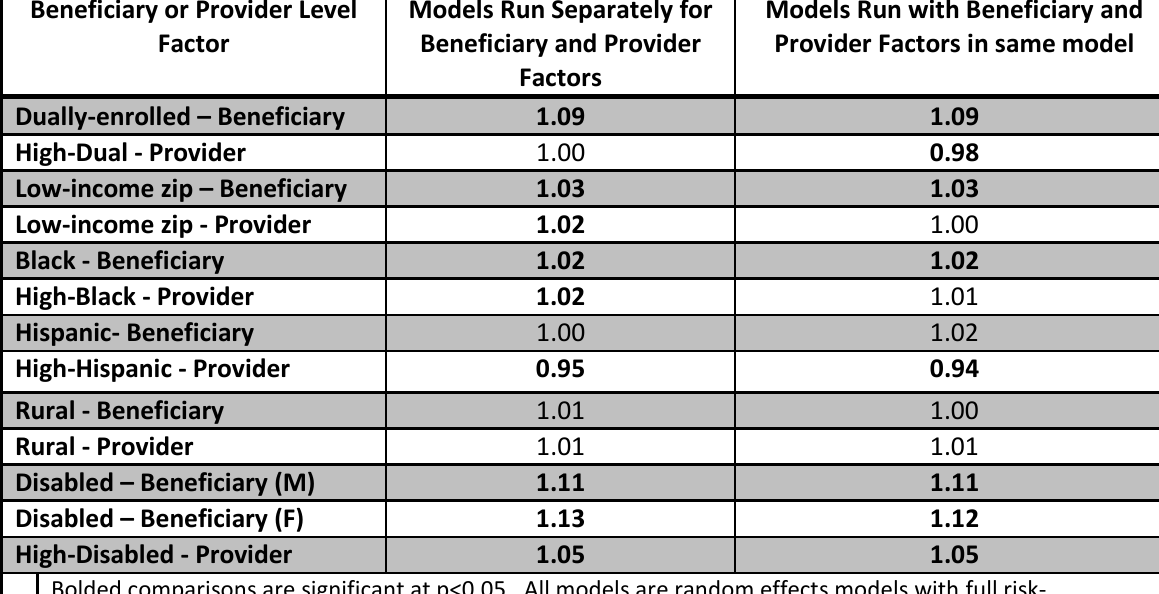
Table 13.9a: Beneficiary versus Provider Factors in